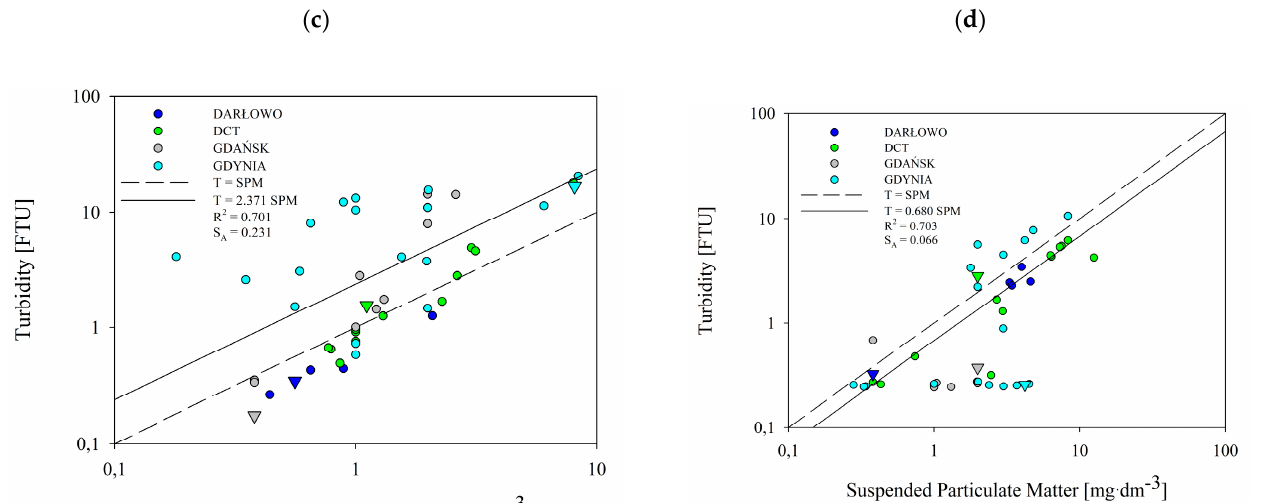
Figure 7. Correlations between in situ turbidity and the concentration of SPM in the near-seabed layer for the spring ( a ), summer ( b ), autumn ( c ), and winter ( d ). Circles depict the sea dumping site points, while triangles depict reference points. Throughout this figure, T also means turbidity.